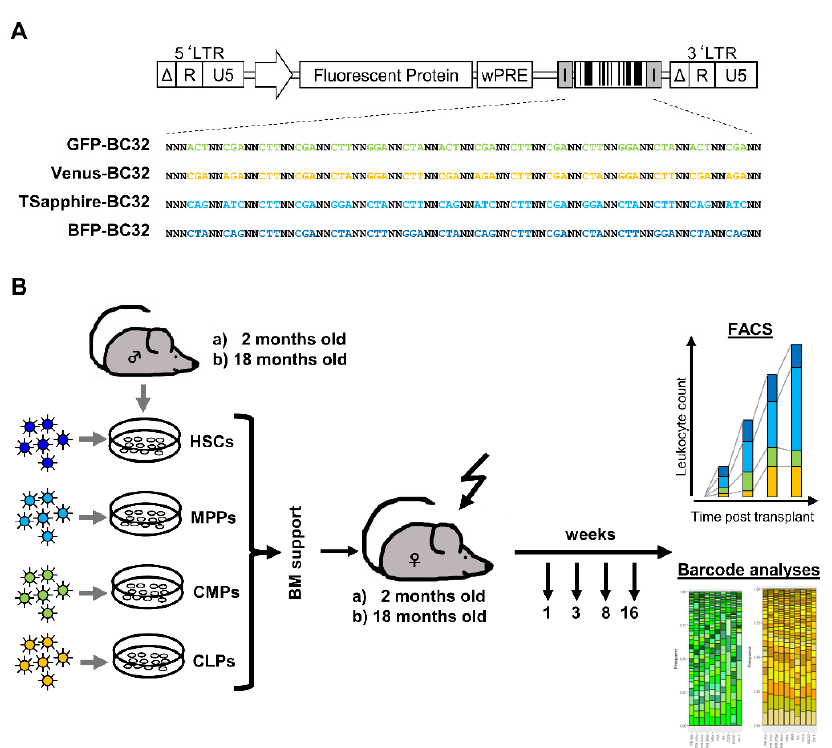
Figure A1. Vector construction and experimental set-up. ( A ) Four different barcoded plasmid libraries based on lentiviral vectors encoding the fluorescent proteins GFP, Venus, T-Sapphire, and BFP were used to produce viral supernatants. The color of ach fluorescent protein is also ciphered by the order of the fixed triplets (34). ( B ) For the murine transplantation experiments, lineage- negative cells from male donor mice ( n = 30; 2 months or 18 months old), were isolated from the bone marrow and sorted by fluorescent-activated cell sorting (FACS) into hematopoietic stem cells (HSCs), as well as the following progenitors: multipotent progenitors (MPPs), common myeloid progenitors (CMPs), and common lymphoid progenitors (CLPs). The four different populations were transduced independently with the four different lentiviral constructs depicted in ( A ). After short-time transduction, the cells were mixed and transplanted together with bone marrow support into lethally irradiated female recipients ( n = 30; 2 or 18 months old). Then, 1, 3, 8 weeks post transplantation and at final analysis (16–18 weeks post transplantation), a small group of animals ( n ≤ 7) were sacrificed, and their hematopoietic organs were taken for flow cytometry analysis and DNA extraction for barcode